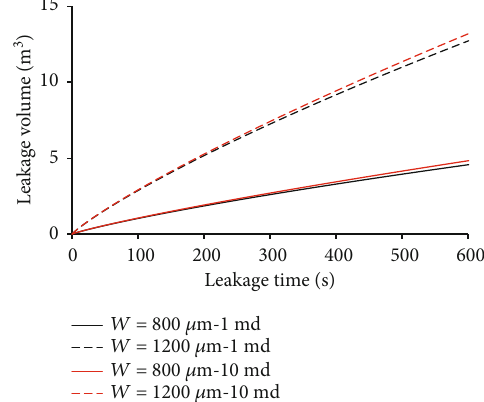
Figure 24: Leakage volume under di ff erent formation permeability and initial width of natural